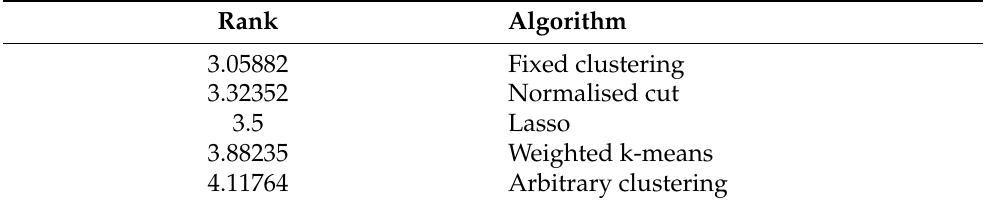
Table 4. Friedman results of the proposed methodology using different feature selection techniques for ROC.